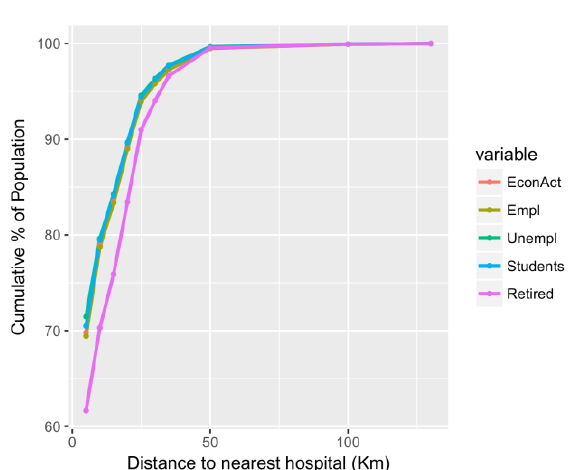
Figure 2. Spatial accessibility to hospitals for age groups